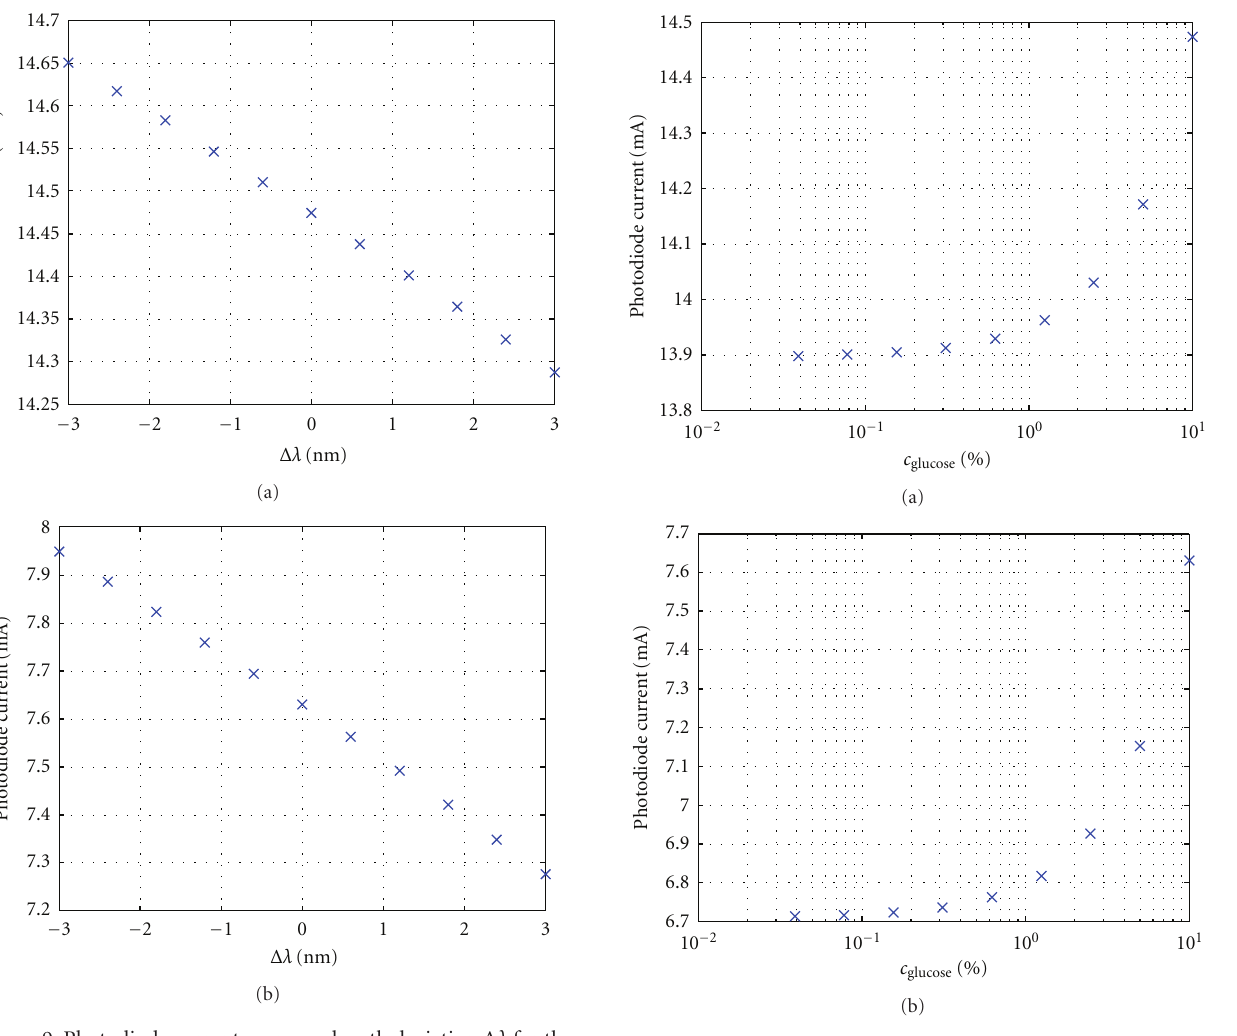
Figure 10: Photodiode current over glucose concentration for the dipole metamaterial (a) and for the EIT metamaterial